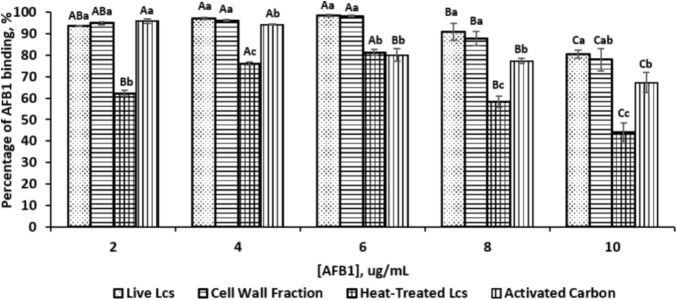
Percentage of AFB1 binding by different Lcs cell components and activated carbon at different concentration of AFB1. Each column represents different samples: dotted, live Lcs; horizontal lines, cell wall fraction; grid, heat-treated Lcs; vertical lines, activated carbon. Aliquots of 1 ml of 109 cells (Lcs live cells; heat-treated cell; cell wall component) and activated carbon were suspended in PBS in the presence of AFB1 at the following concentrations: 2, 4, 6, 8, and 10 μg/mL. Upon incubated for 1 h at 37°C, samples were subjected to centrifugation. The supernatant was collected for unbound AFB1 analysis by ELISA. Data are means from triplicate experiments (error bars indicate mean ± SD). Means between different Lcs cell components and activated carbon within the same concentration with different lowercase letters (a, b, c) are significantly different (p < 0.05); Means between different concentration of the same Lcs cell component as well as activated carbon with different uppercase letters (A, B, C) are significantly different (p < 0.05).